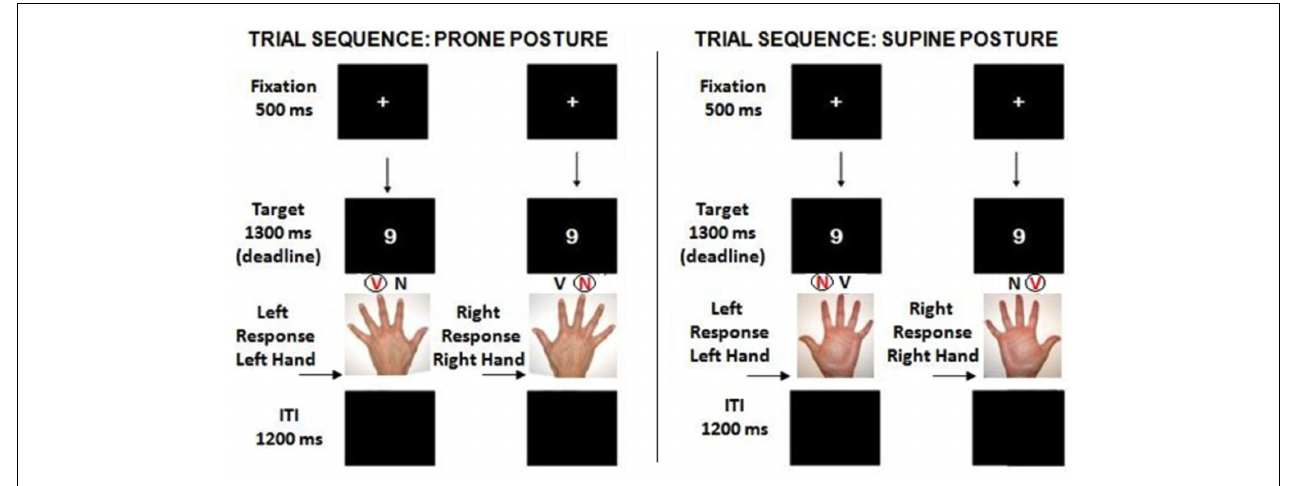
left index and middle finger, and the experiment was divided in two main parts according to which hand was used to respond. Since nine is large in the experimental range, the right-side key is compatible with a left-to-right representation of the numbers 1–9, and the left-side key is incompatible.